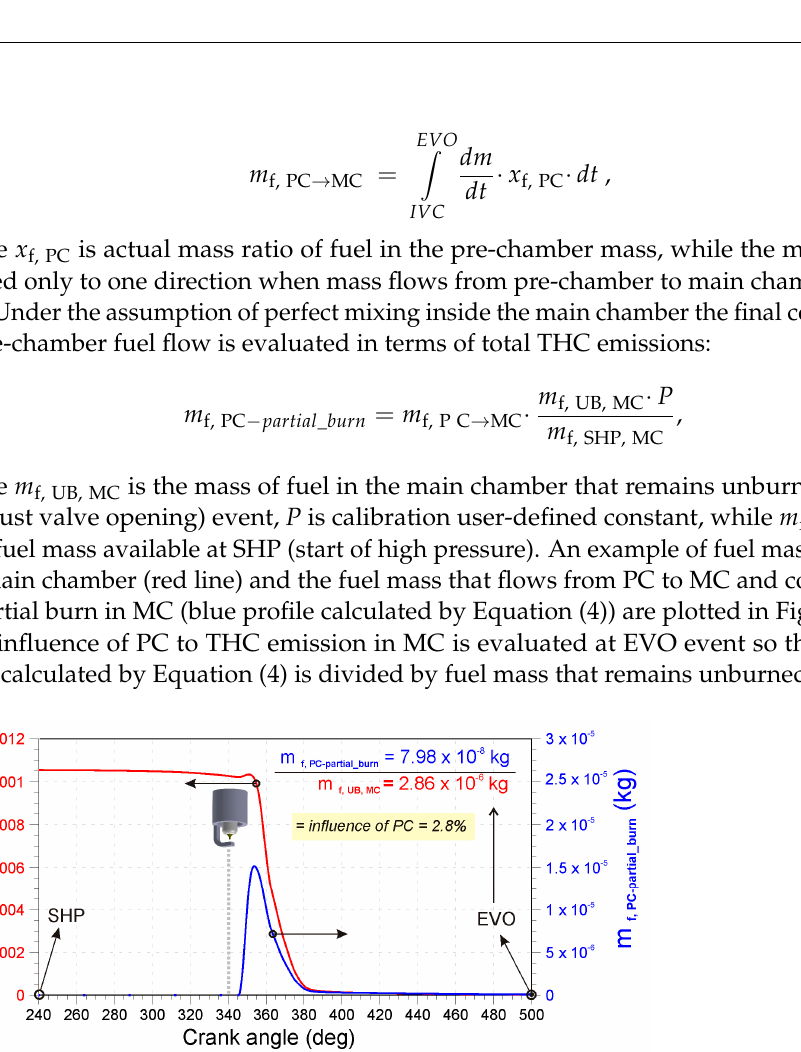
Figure 6. Contribution of fuel mass from PC to MC on total partial burn effect in MC—example for operating point at exhaust air excess ratio of 1.8.